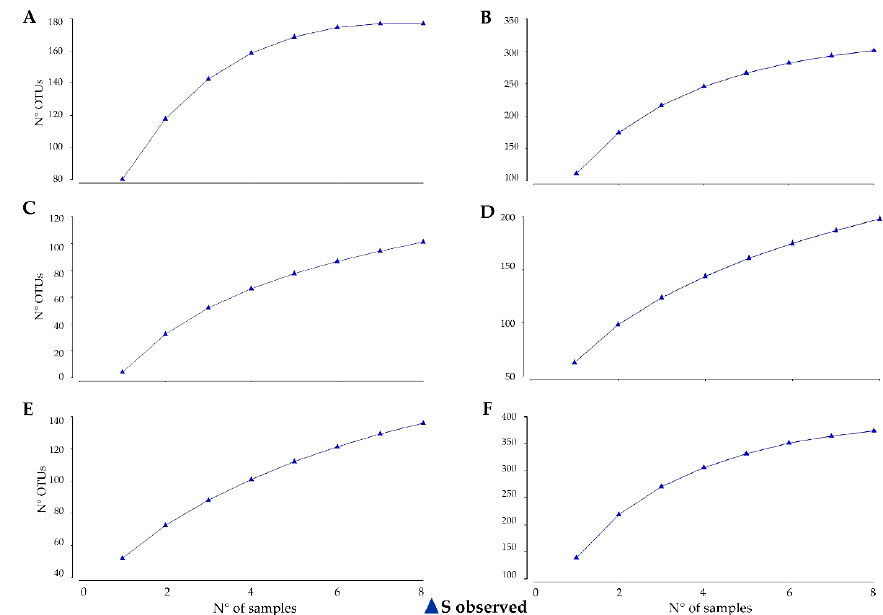
Figure 2. Fungal and bacterial species accumulation curves produced by the analytical formulae and randomizing the samples values were obtained using observed species (Sobs) counts and plotted against increasing numbers of samples. ( A , B ) Battleship Promontory, fungi and bacteria, respectively; ( C , D ) Trio Nunatak, fungi and bacteria, respectively; ( E , F ) Mt New Zealand, fungi and bacteria, respectively.